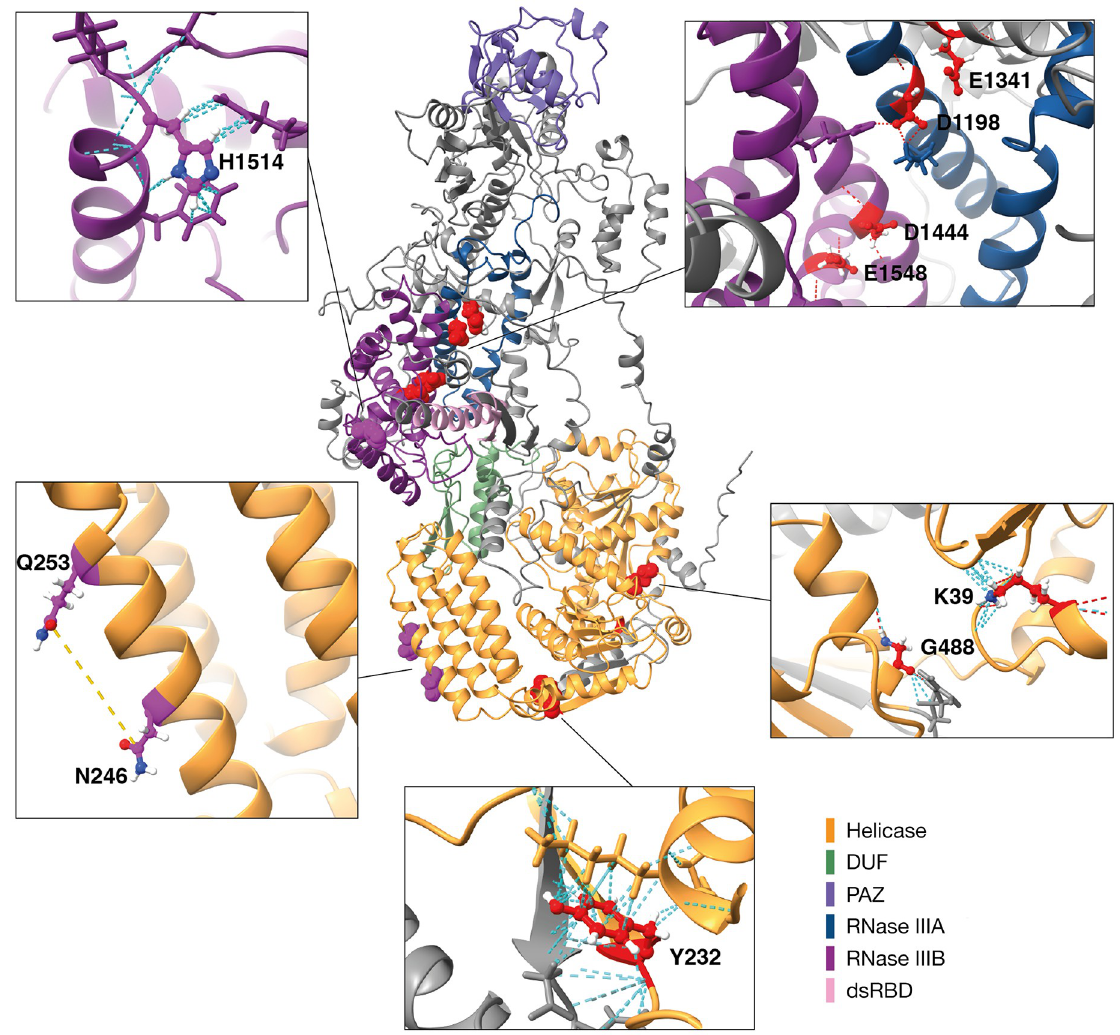
Fig 3. Locations of conserved amino acids critical for Aaeg Dcr2 function can be predicted and are distributed between surface and buried residues. Center, AlphaFold prediction (mean pLDDT score = 81.4) for the structure of WT Aaeg Dcr2 (GenBank ID: AAW48725), colored by predicted domains from annotations and Interproscan. Residues representing conserved amino acids involved in Dcr2 activity and natural haplotype variants are highlighted in red and purple, respectively. Inset panels show enlarged representations of conserved amino acid residues targeted in mutagenesis experiments, with dashed lines showing contacts in red, hydrogen bonds in cyan, and distances in yellow. Clockwise from upper right: loss-of-function mutations in the RNase III domains line a predicted cleft in the core of the protein; G488 and K39 are forecast to be buried near the surface of the helicase domain; Y232 appears to form hydrogen bonds and extensive contacts with a neighbouring α -helix (residues 360–374) and β -strand (residues 496–502); natural haplotype variant residues N246 and Q253 (distance = 10.71 Å ) are likely positioned on the exposed surface of the helicase domain; H1514 is seen at the surface exposed tip of an α